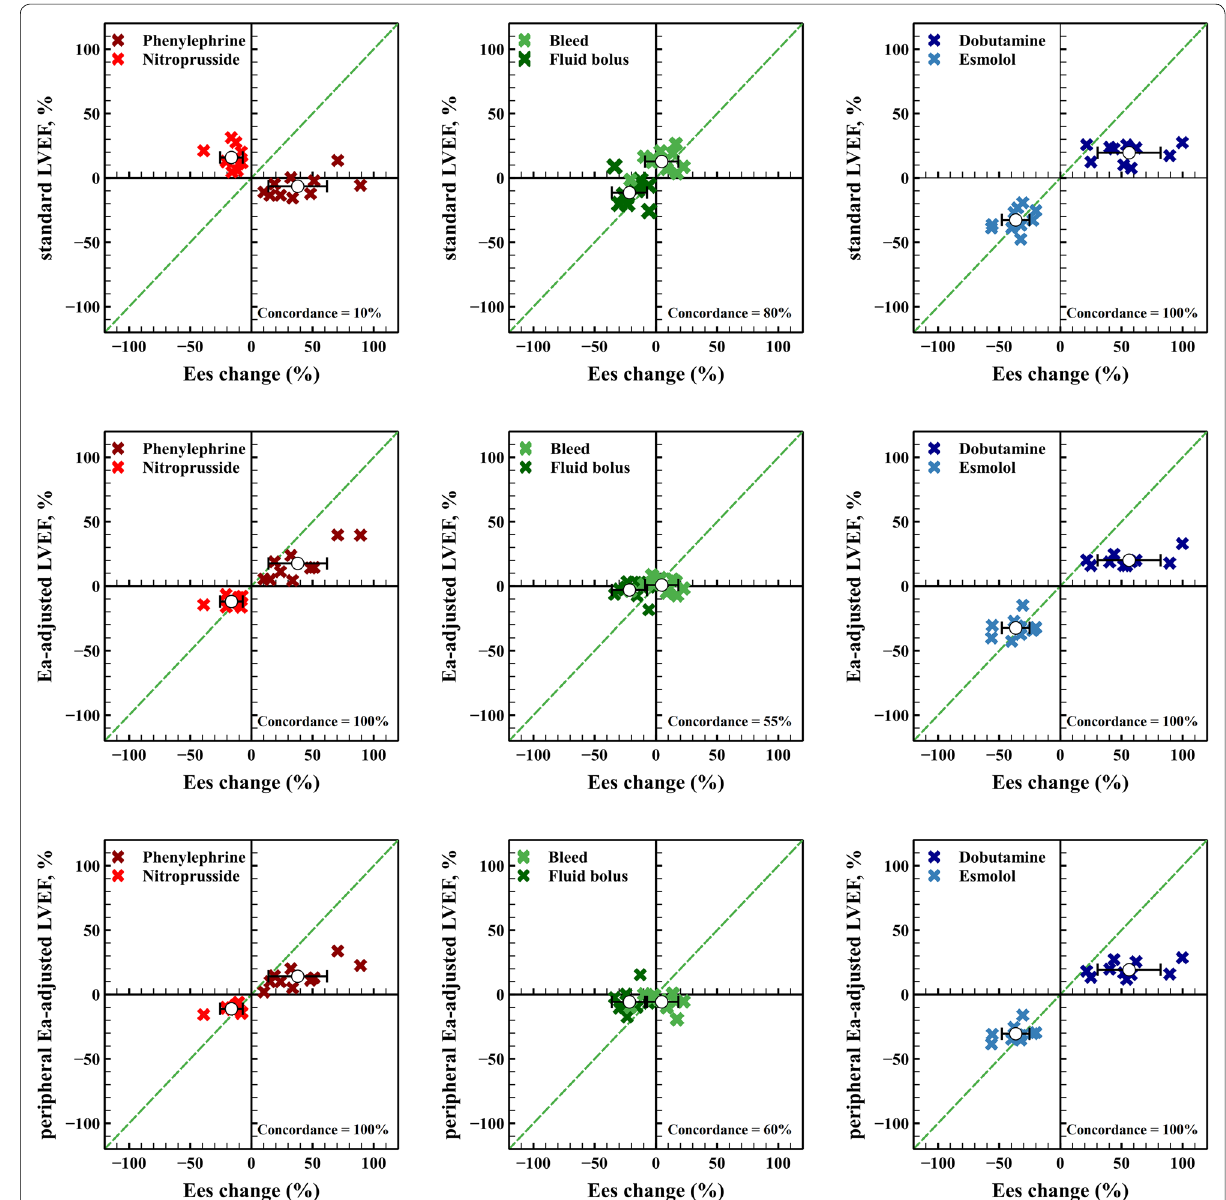
Fig. 3 Concordance analysis for percentage changes in different approaches for estimating left ventricular contractility and end-systolic elastance (Ees) during different experimental stages. Four-quadrant plots showing the relationship between percentage changes in left ventricular (LV) end-systolic elastance (Ees) and different approaches studied: standard LVEF calculation, LVEF adjusted to effective arterial elastance (Ea left = ventricular end-systolic pressure/stroke volume) and peripheral Ea-adjusted LVEF (Ea periph radial mean arterial pressure/stroke volume). Excellent = trending capability was assumed when 90% of the data lie in the right-upper and the left-lower quadrants. Open circles with bars represent the ≥ mean percentage change on each stage. Dashed green lines represent the line of